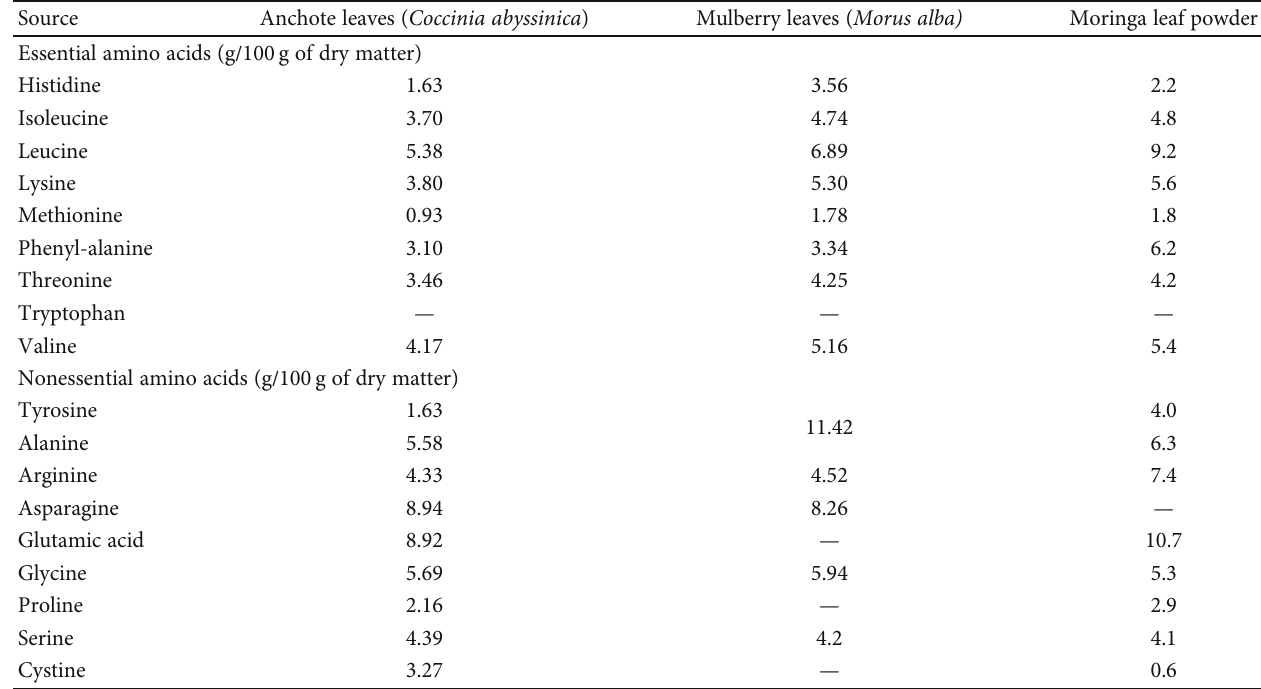
Table 5: Comparative amino acid pro fi le of di ff erent consumable leaf powders with Moringa leaf powder.